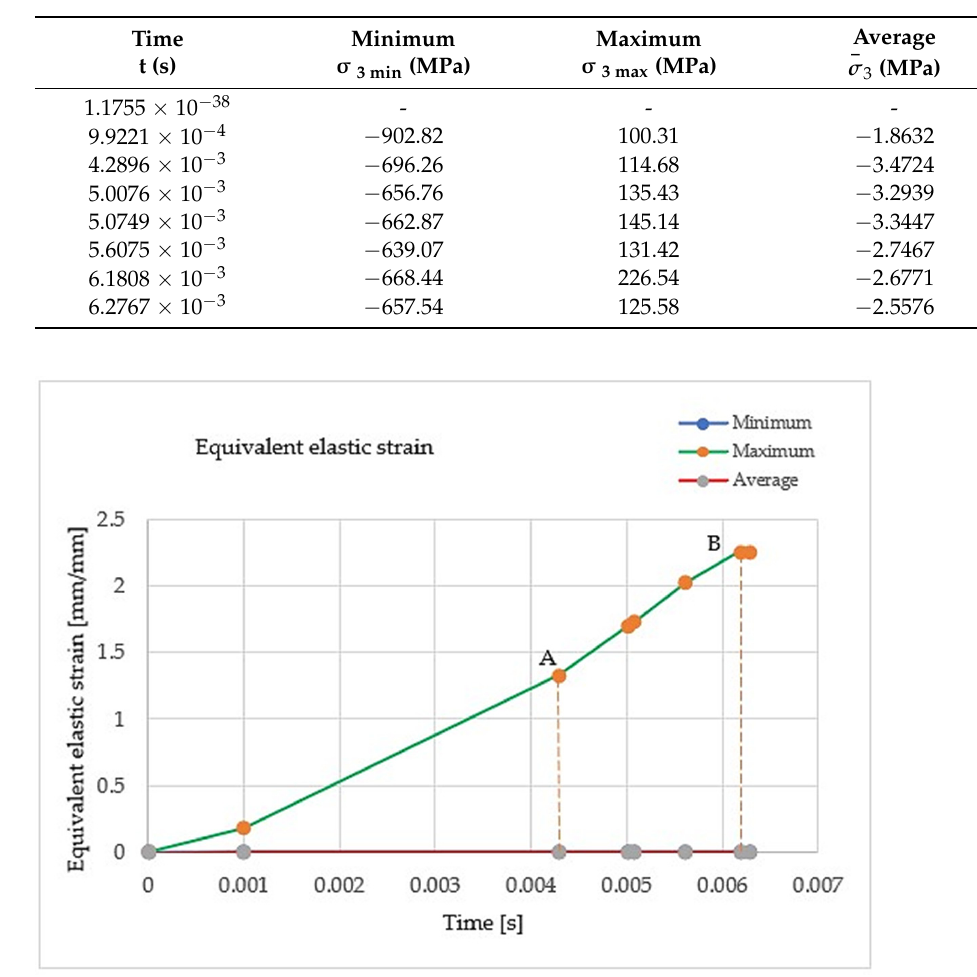
Figure 11. Diagram of equivalent elastic strain. Table 4. Equivalent Elastic Strain.